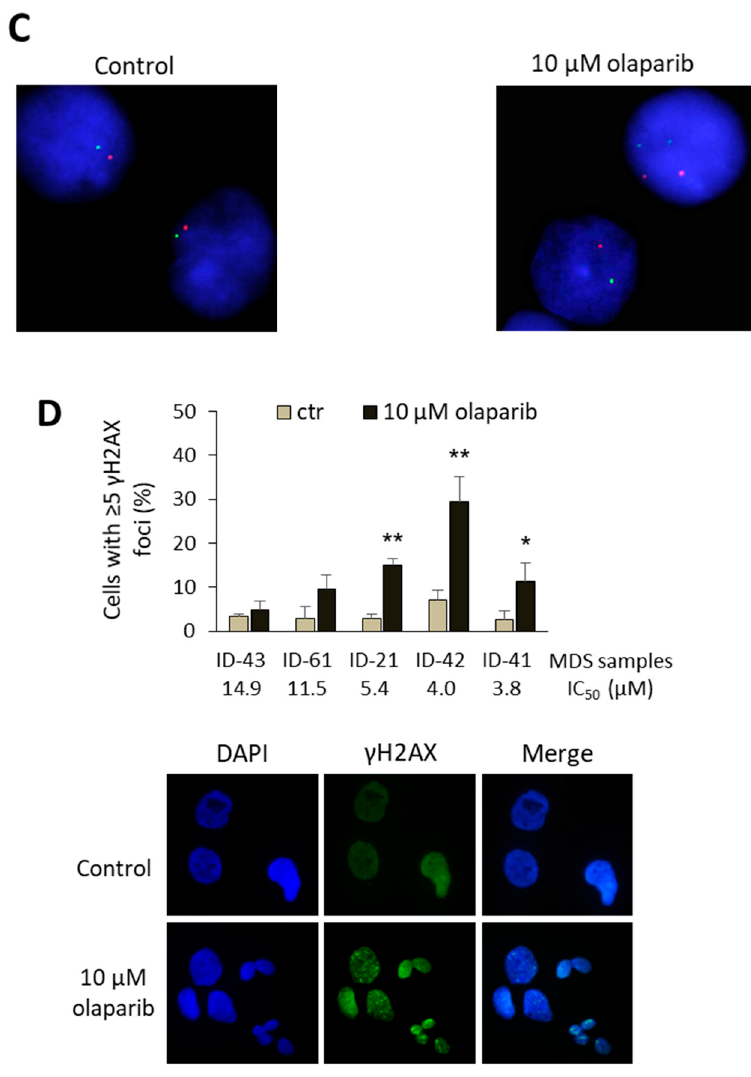
Figure 2. Apoptosis and DNA damage in primary MDS in vitro cultures treated with olaparib. ( A ) Percentages of apoptotic cells (Annexin V positive / PI negative), detected by FACS analysis, in gated myeloid cells after exposure to graded concentrations of olaparib (7 days) compared to untreated cultured cells. Samples were classified in order of decreasing olaparib IC 50 values. ( B ) Histograms indicate the mean percentage ± SD of apoptotic and necrotic cells (Annexin V positive / PI positive), detected within the myeloid and lymphocytic populations, respectively. Data refer to six MDS samples after exposure to graded concentrations of olaparib for 7 days compared to untreated cultured cells. Olaparib induces apoptosis in the myeloid MDS cell compartment, while sparing lymphocytes. Statistical analysis was performed on apoptotic cells (Annexin V positive / PI negative cells) by Friedman followed by Dunn’s test. ( C ) Interphase FISH analysis of representative MDS cells with 7q deletion (ID-75). Images were taken at 100 × magnification. Nuclei with deletions involving both critical regions at 7q22 and 7q36 show one red and one green signal only, whereas cytogenetically normal cells show two red and two green signals. In the control group, 75% of cells showed the 7q deletion, whereas in the olaparib-treated group this percentage dropped to 50%. ( D ) Analysis of γ H2AX foci by immunofluorescence after 72 h of exposure to 0 and 10 µ M olaparib. Values are the mean percentage ± SD of the cells with ≥ 5 γ H2AX foci in four quadrants, containing at least 50 cells each. Statistical analysis was performed by Mann-Whitney test. Representative nuclei of MDS cells untreated or exposed to 10 µ M olaparib are shown. Cells were probed with γ H2AX (green stain) and DAPI (blue). Images were taken at 40 × magnification. * p < 0.05, ** p < 0.01, *** p < 0.001 vs. untreated control.